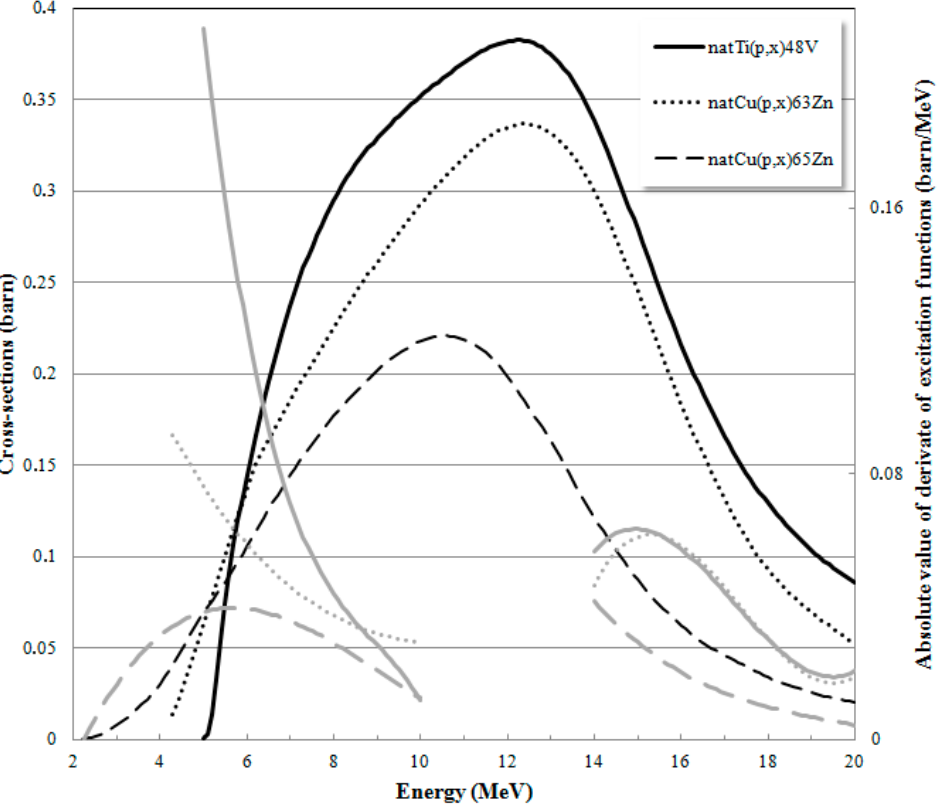
Figure 1. Excitation functions of the monitor reactions of interest (black lines) and absolute values of their derivates in the energy ranges of interest (grey lines).